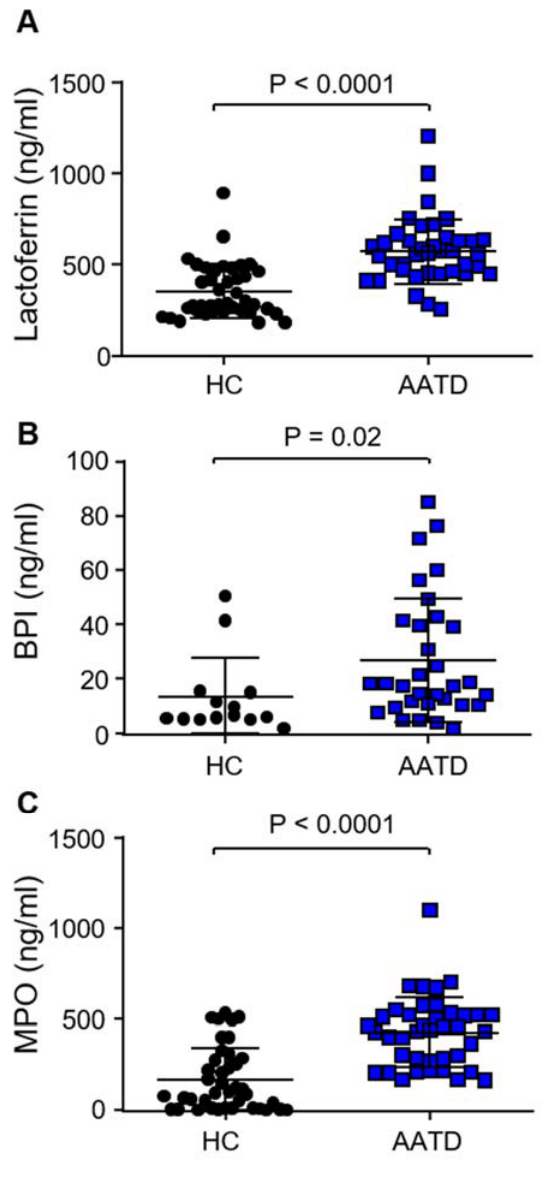
Figure 5. Increased plasma levels of neutrophil degranulated components in AATD. ( A ) Lactoferrin ( p < 0.0001, n = 40 subjects per group, Mann–Whitney U test), ( B ) BPI ( p = 0.02, n = 14 and n = 32 for HC and AATD respectively, Mann–Whitney U test) and ( C ) MPO ( p <0.0001, n = 40 subjects per group, Mann–Whitney U test) quantified by ELISA and expressed as ng/mL, were significantly higher in plasma of AATD individuals compared to HC donors. All measurements are mean ± SEM from biological replicates.